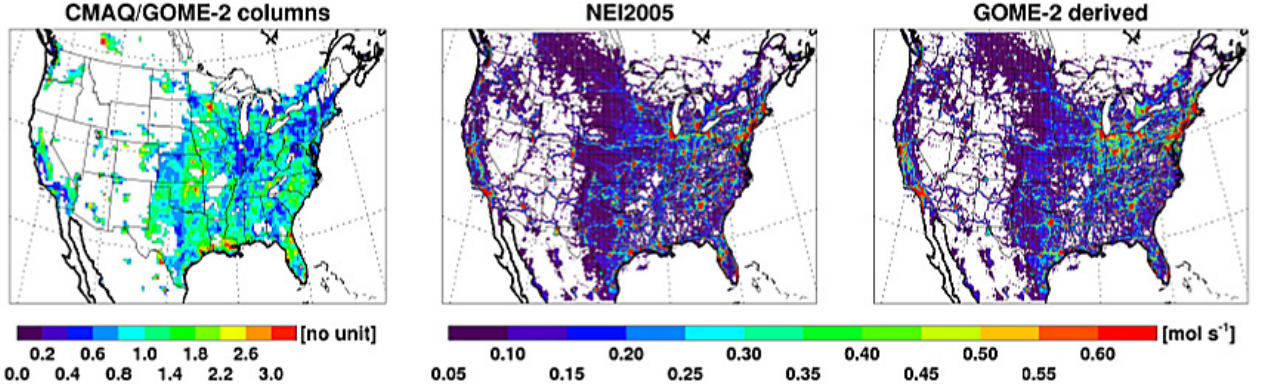
Fig. 9. The ratio of the monthly-averaged CMAQ NO 2 columns versus GOME-2 NO 2 columns (left panel, both GOME-2 and CMAQ column data are interpolated for 36km for this comparison), the monthly-averaged NO x emissions from EPA National Emissions Inventory 2005 (NEI 2005, middle panel, 462GgN over the US) and the monthly-averaged NO x emissions from the GOME-2-derived emissions inventory (right panel, 426GgN over the US) for August